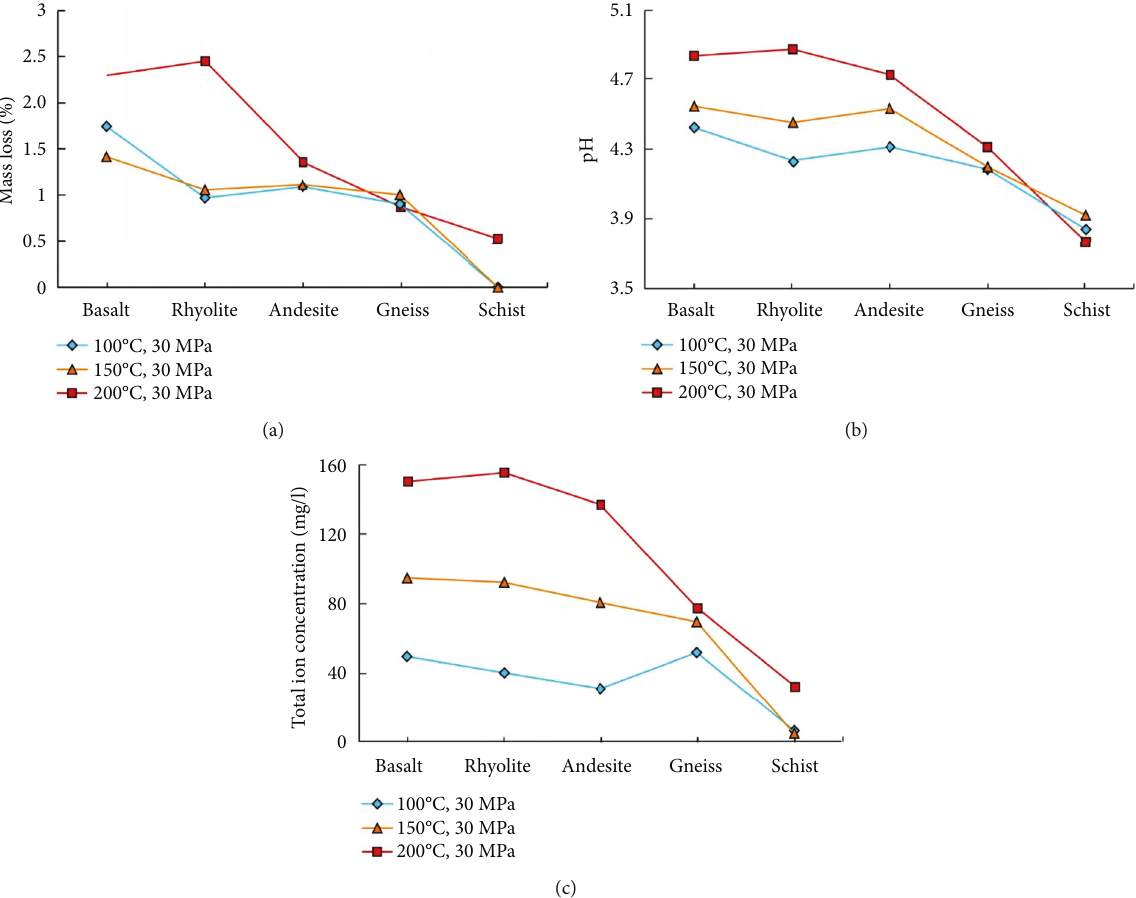
Figure 11: The percentage of mass loss, pH, and total ion concentration of di ff erent types of cuttings under di ff erent temperature and pressure conditions. (a) Percentage of mass loss, (b) pH, and (c) total ion concentration. Table 4: Measured and calculated data table of methane inclusions in the well section with microfractures. Methane inclusion density Homogenization temperature No. Depth (m) Stratum (g/cm 3 of inclusions ( ° C)